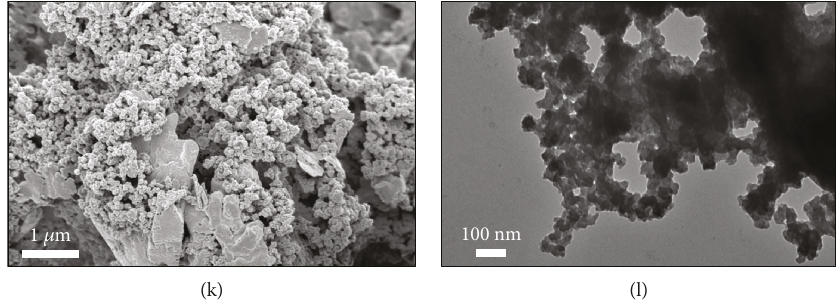
Figure 5: (a) Example of channel-forming travertine at CPS. Photo taken May 2018; channel bounded by snow. (b) Double-polished thin section of channel travertine overhang showing laminated fabric. (c) SEM-BSD micrograph of area shown in (b). (d) SEM-BSD micrograph of area shown in (c). (e, f) SEM-BSD micrographs of areas shown in (d) showing two types of micritic fabrics: (e) microcrystalline grains embedded within calcite (circle) and (f) abrupt boundary layers (arrows). (g) SEM-BSD micrograph of area shown in (d). Dashed square shows area milled in (h) with thick bar showing milled face. (h) SEM in-lens micrograph of FIB-milled face shown in (g). (i) SEM in-lens micrograph of area shown in (h). (j) SEM-SE micrograph of area shown in (i). Note trapped gas inclusions (asterisks) and microcrystalline grains (arrow) within the calcite matrix. (k) SEM in-lens micrograph of aggregates of microcrystalline FeS grains intermixed with sur fi cial sediments from a CPS out fl ow. (l) TEM micrograph of microcrystalline FeS aggregates from a CPS out fl ow. Note morphological similarities to microcrystalline grains in